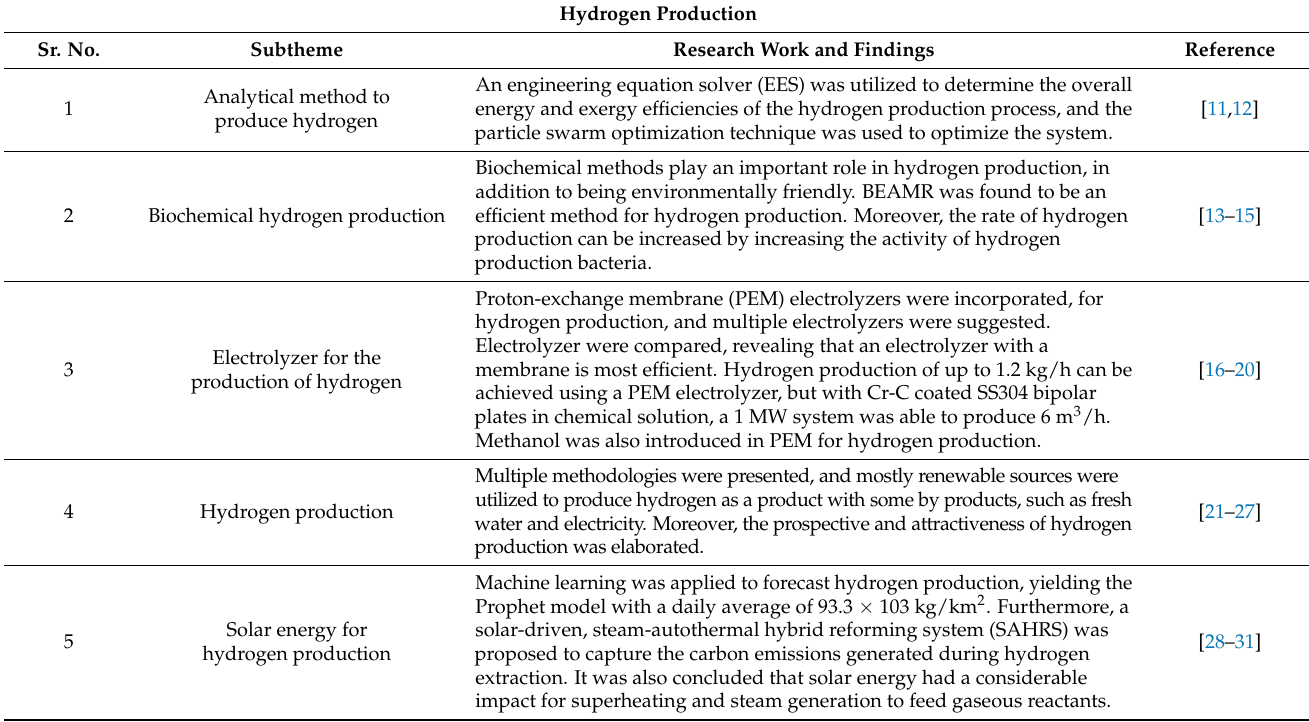
Table 1. Theme-based literature